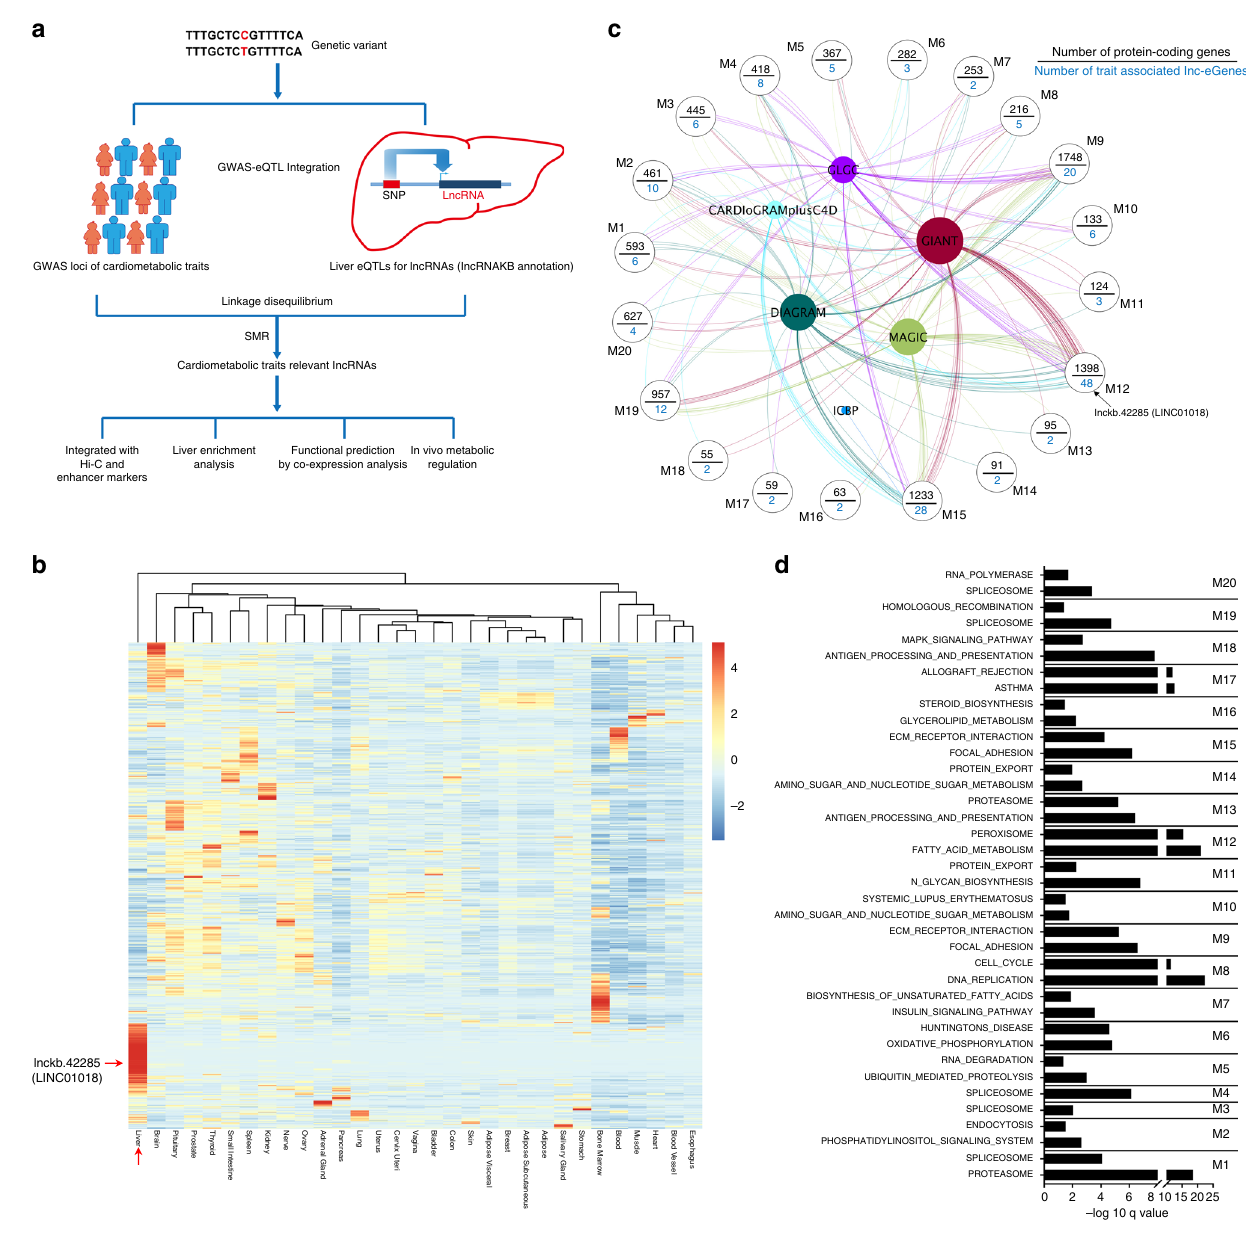
Fig. 1 Identi fi cation and functional prediction of human liver lnc-eGenes. a Flowchart depicting a pipeline for identifying potentially functional human lncRNAs by integration of GWAS and eQTL data and by further bioinformatic and experimental analyses. b Heatmap of tissue expression Z score for the cardiometabolic trait-associated lnc-eGenes. LINC01018 and liver tissue were pointed out by red arrows. c Co-expression module analysis of cardiometabolic trait-associated lnc-eGenes. The modules with at least one signi fi cant KEGG pathway and including 2 or more trait associated lnc-eGenes are shown. d KEGG pathway analysis of protein-coding genes in each module; only the top two most signi fi cant pathway for each module are